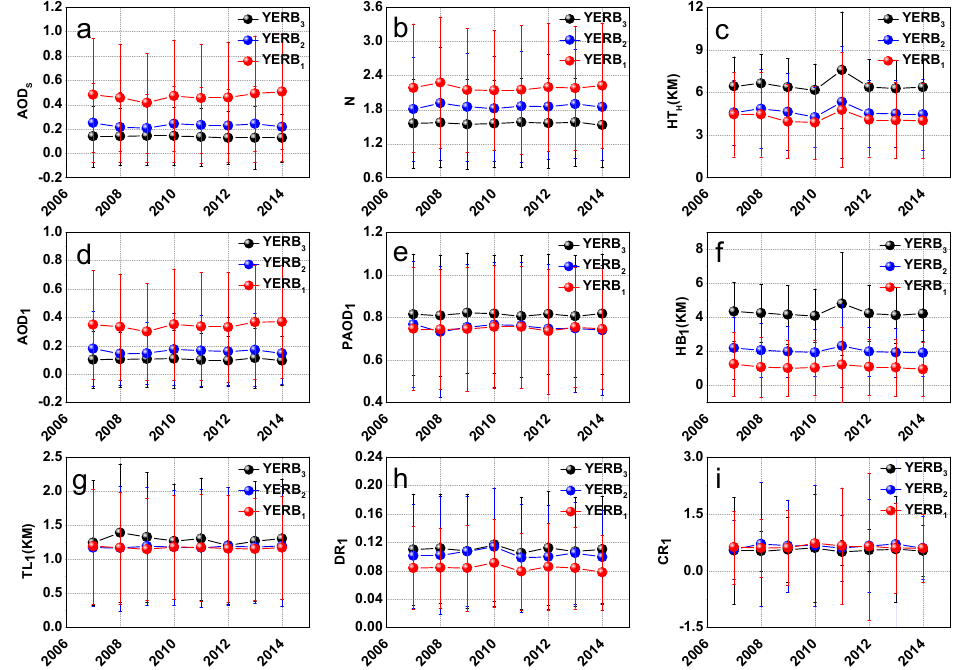
Figure 2. Interannual variation in optical and physical properties of the lowest aerosol layers in three sub-regions of the Yellow River Basin (YERB): ( a ) sum of aerosol optical depths (AODs) from all aerosol layers, ( b ) amount (number) of aerosol feature layers (N), ( c ) height of the highest aerosol layer top (HT H ), ( d ) AOD of the lowest aerosol layer (AOD 1 ), ( e ) AOD proportion of the lowest aerosol layer (PAOD 1 ), ( f ) height of the lowest aerosol layer base (HB 1 ), ( g ) thickness of the lowest aerosol layer (TL 1 ), ( h ) depolarization ratio of the lowest aerosol layer (DR 1 ), and ( i ) color ratio of the lowest aerosol layer (CR 1 ), from January 2007 to December 2014 (the wavelength is 532 nm).